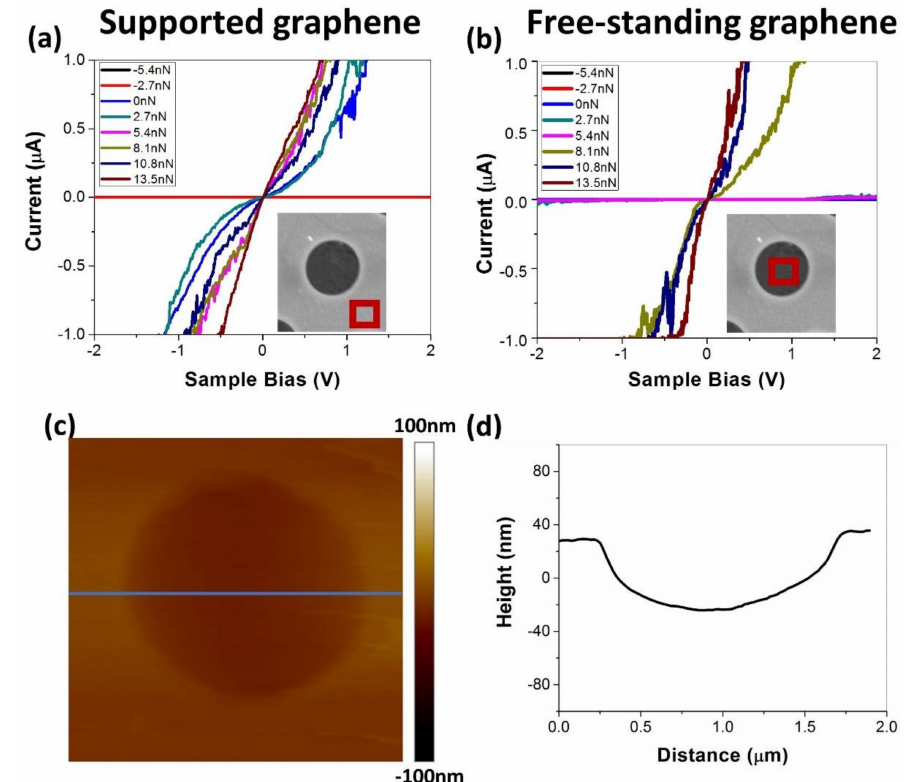
Figure 2. I–V characteristics of ( a ) supported graphene and ( b ) free-standing graphene as a function of the applied load. In the case of the supported graphene, larger current is observed at the lower loads. The 2.7 nN steps were selected to provide a uniform distribution of applied loads. ( c ) Height profile scan indicates ( d ) ~40 nm sagging of graphene in the free-standing area resulting from the transfer